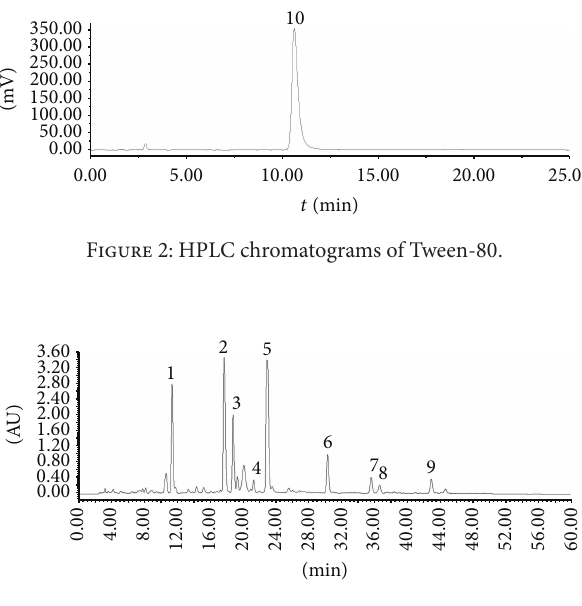
Figure 3: The chromatogram of Reduning injection: (1) neochloro- genic acid; (2) chlorogenic acid; (3) cryptochlorogenin acid; (4) caffeic acid; (5) geniposide; (6) secoxyloganin; (7) isochlorogenic acid B; (8) isochlorogenic acid A; (9) isochlorogenic acid C.